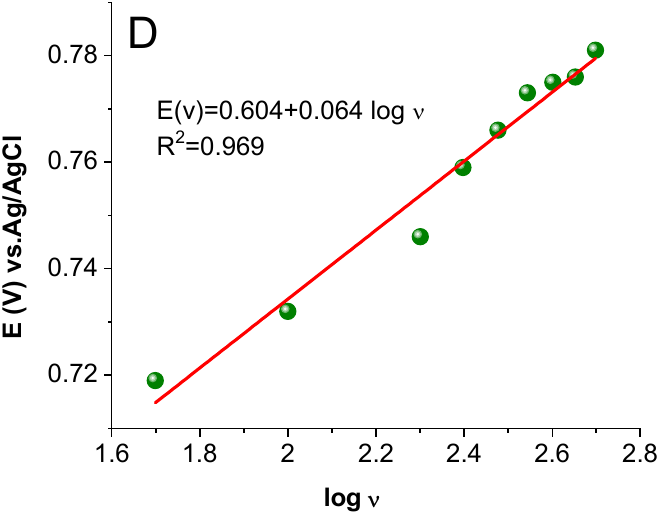
Figure 9. ( A ) Effect of change in scan rate on the CV in the presence of 250 μM CR in 0.1 M ABS at pH 6.5, ( B ) plot of current vs. ν 1/2 , ( C ) plot of log I vs. log ν and ( D ) plot of E vs. log ν.